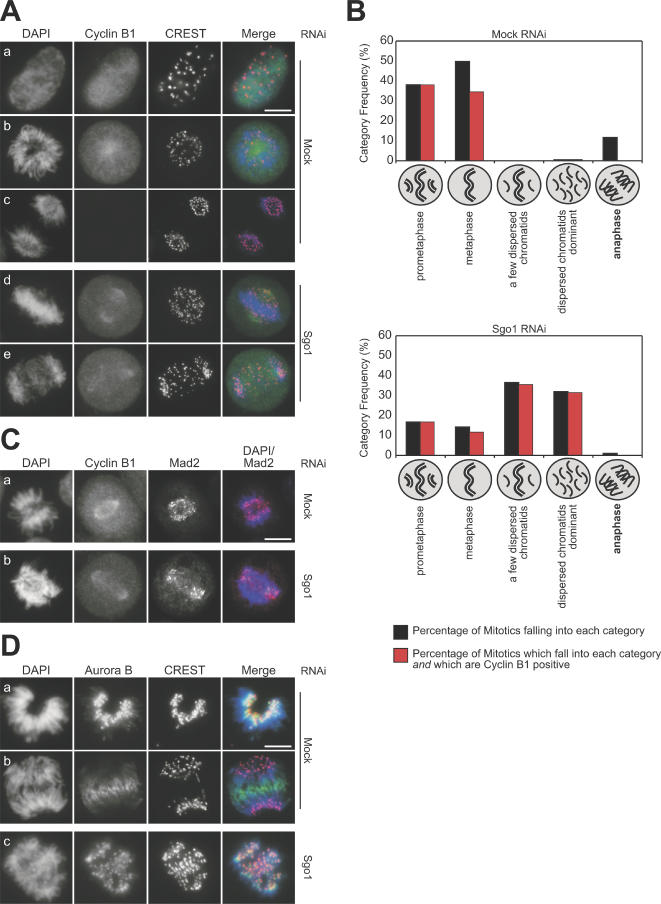
Sgo1-Depleted Cells Arrest in a Prometaphase-like State(A) Sgo1 depletion prevents destruction of cyclin B1. Synchronised HeLa cells mock-treated or transfected with Sgo1 siRNA were processed for immunofluorescence microscopy using cyclin B1 antibodies (green) and CREST sera (red) 11 h after release from the second thymidine block. DNA was visualized by DAPI staining (blue). In mock-treated cells, cyclin B1 staining in prophase (a) and in prometaphase (b) disappears as cells segregate their chromosomes upon anaphase entry (c). Sgo1-depleted cells which segregate chromosomes asynchronously and arrest in a mitotic state retain preanaphase levels of cyclin B1 (d–e). Bar = 10 μm.(B) Mitotic cells shown in (A) were classified into five categories based on DAPI-labelled chromosome configuration, and scored for presence or absence of cyclin B1 staining. Black bars represent the frequency of each category, and red bars represent the percentage of cells that fall into each category and are positive for cyclin B1 staining.(C) Recruitment of Mad2 in cells depleted of Sgo1. Cells prepared as in (A) were stained with cyclin B1 antibody, and counterstained with Mad2 antibody (red) and DAPI to visualize DNA (blue). (a) Prometaphase mock-transfected cells show Mad2 staining at kinetochores, which is lost as the metaphase plate assembles and disappears before cells enter anaphase (unpublished data). (b) Sgo1-transfected cells which have prematurely segregated sisters remain positive for Mad2 kinetochore staining. Bar = 10 μm.(D) Aurora B remains at centromeres in Sgo1-depleted cells. Cells prepared as in (A) were stained with Aurora B antibody (green) and counterstained with CREST antiserum (red), and DAPI to visualize DNA (blue). In prometaphase (a) mock-transfected cells, Aurora B is found at centromeres before relocalizing to the central spindle as cells enter anaphase (b). In Sgo1 transfected cells that show precocious sister separation, Aurora B remains localized at centromeres (c).